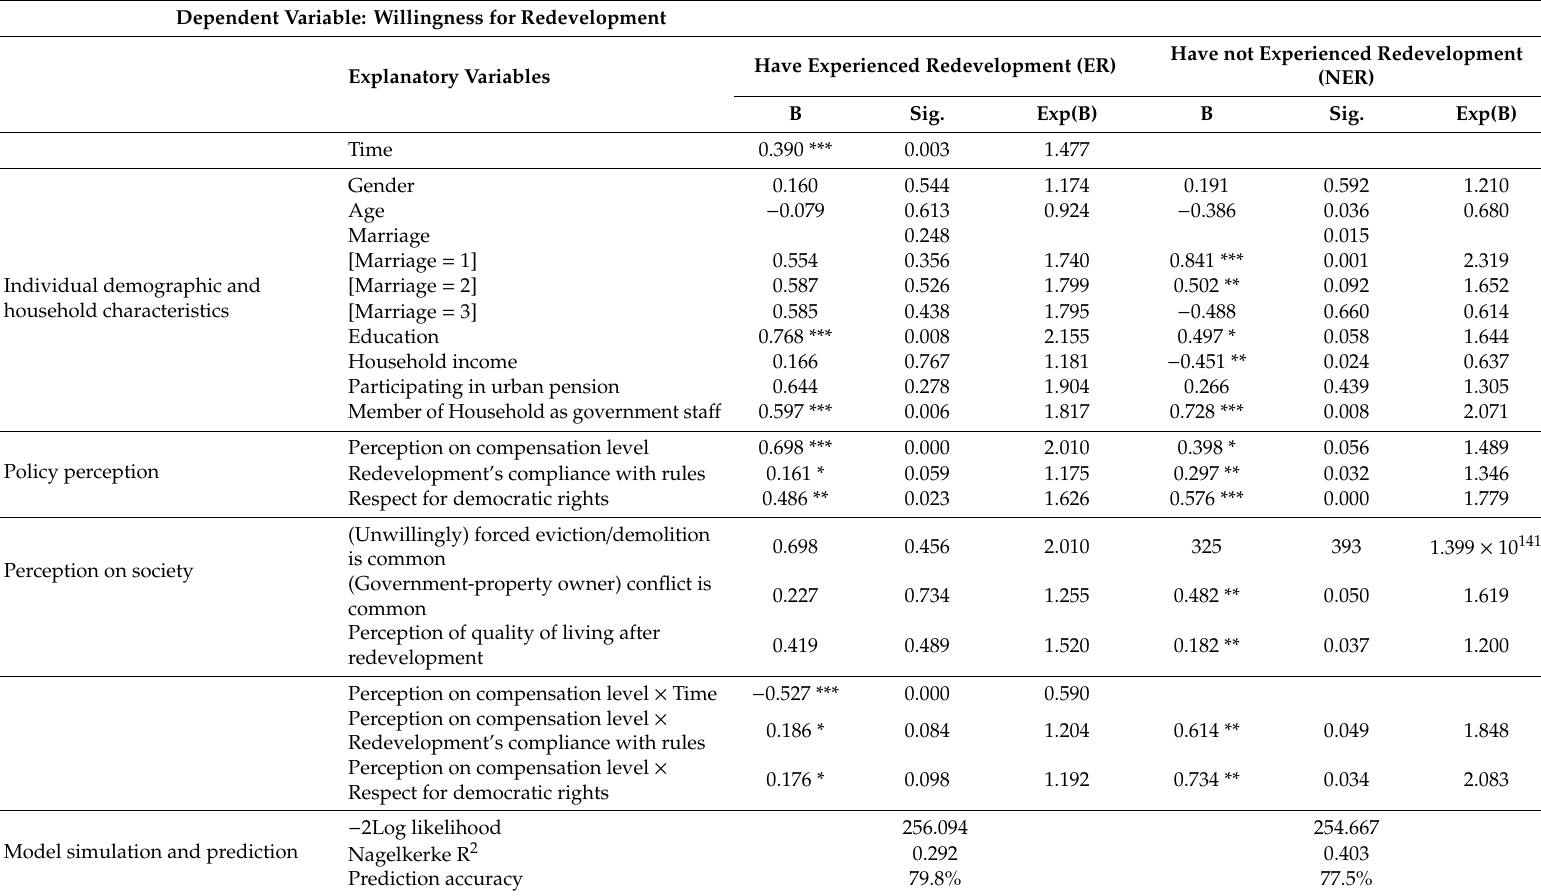
Table 9. Redevelopment Experience and Willingness for Redevelopment (Interaction terms